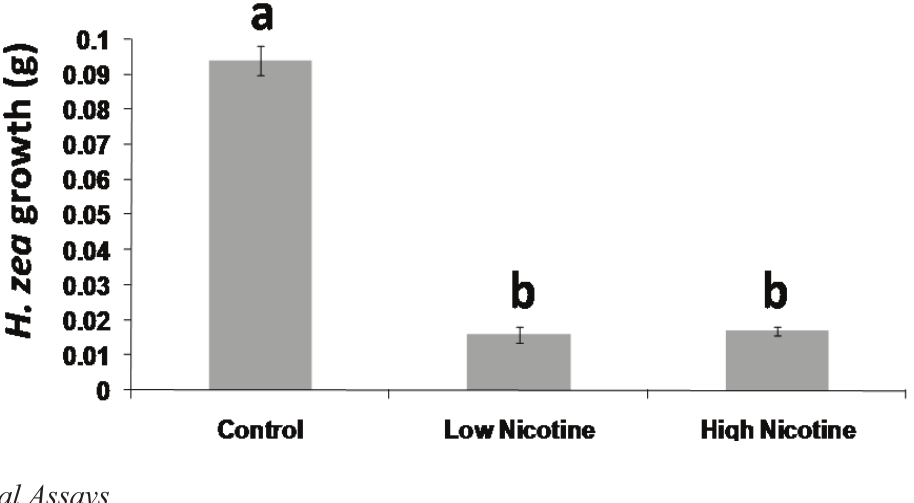
Figure 1. Growth bioassay. Helicoverpa zea neonates feeding on artificial control diet gained significantly more mass over a five-day period than neonates feeding on artificial diet laced with Low (0.75 µg nicotine/mg diet) and High (1.5 µg nicotine/mg diet) concentrations of nicotine. (Control N = 72, Low N = 95, High N = 47, Fishers LSD. p = 0.0025).